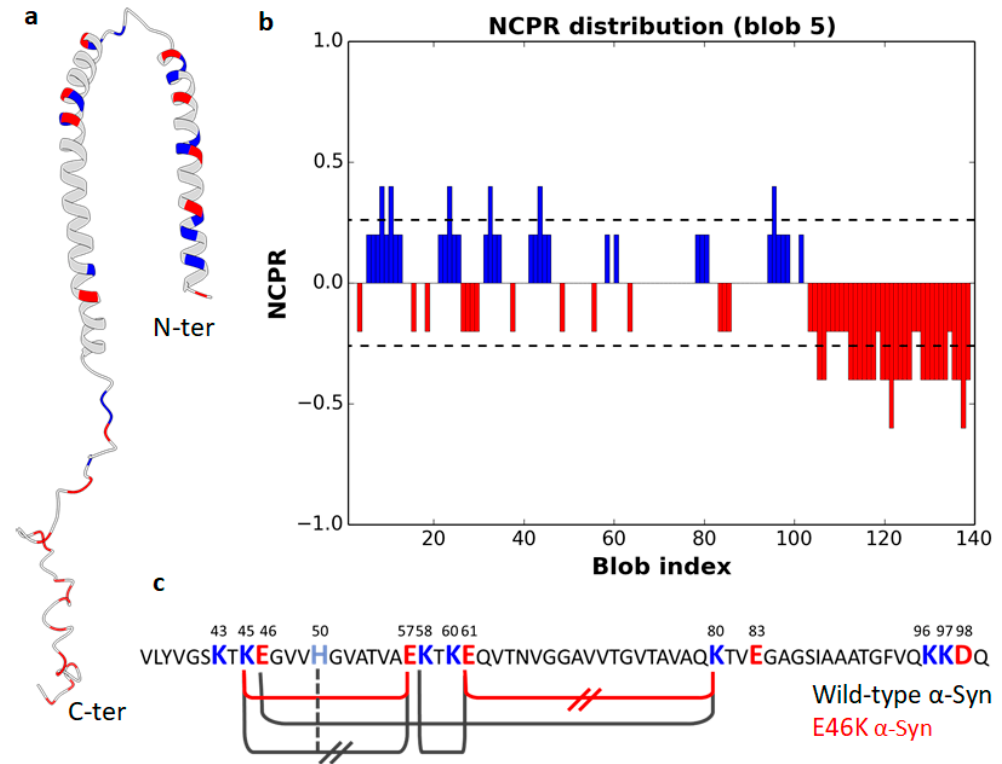
Figure 4. Charge density and distribution of α -Syn. ( a ) Cartoon representation of an NMR structure of micelle-bound human α -Syn (PDB 1XQ8; [118]). Image created with UCSF Chimera [119]. ( b ) NCPR profile along the linear sequence of α -Syn. The blue and red peaks denote positive and negative charges, respectively (plot obtained by CIDER, [11]). ( c ) Primary sequence of the wild-type α -Syn fibril core (aa 37–99). Charged residues are shown in colored bold letters and those interacting in the structures of acetylated wild-type (PDB 6A6B; [120]) and E46K (PDB 6L4S; [121]) α -Syn fibrils are connected by black and red solid lines, respectively. Intermolecular interactions are marked by transverse parallel lines. Figure adapted from [121].